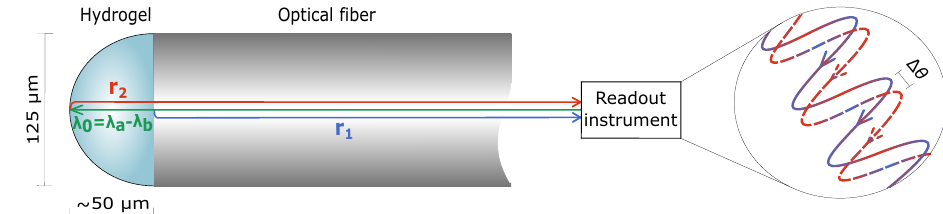
Figure 6. Schematic illustration of the optical set-up for determination of changes in hydrogel swelling. A wavelength range λ a − λ b from 1530 to 1560 nm used as the incident light was reflected at both the fiber-gel ( r 1 ) and the gel-solution ( r 2 ) interfaces yielding a net reflected interference wave. The optical length within the hydrogel, ∆ l o , was determined with high accuracy from the phase change, ∆ θ , from the start of the measurement to the time ∆ t . The gel at the tip of the optical fiber adopts a near half-spherical